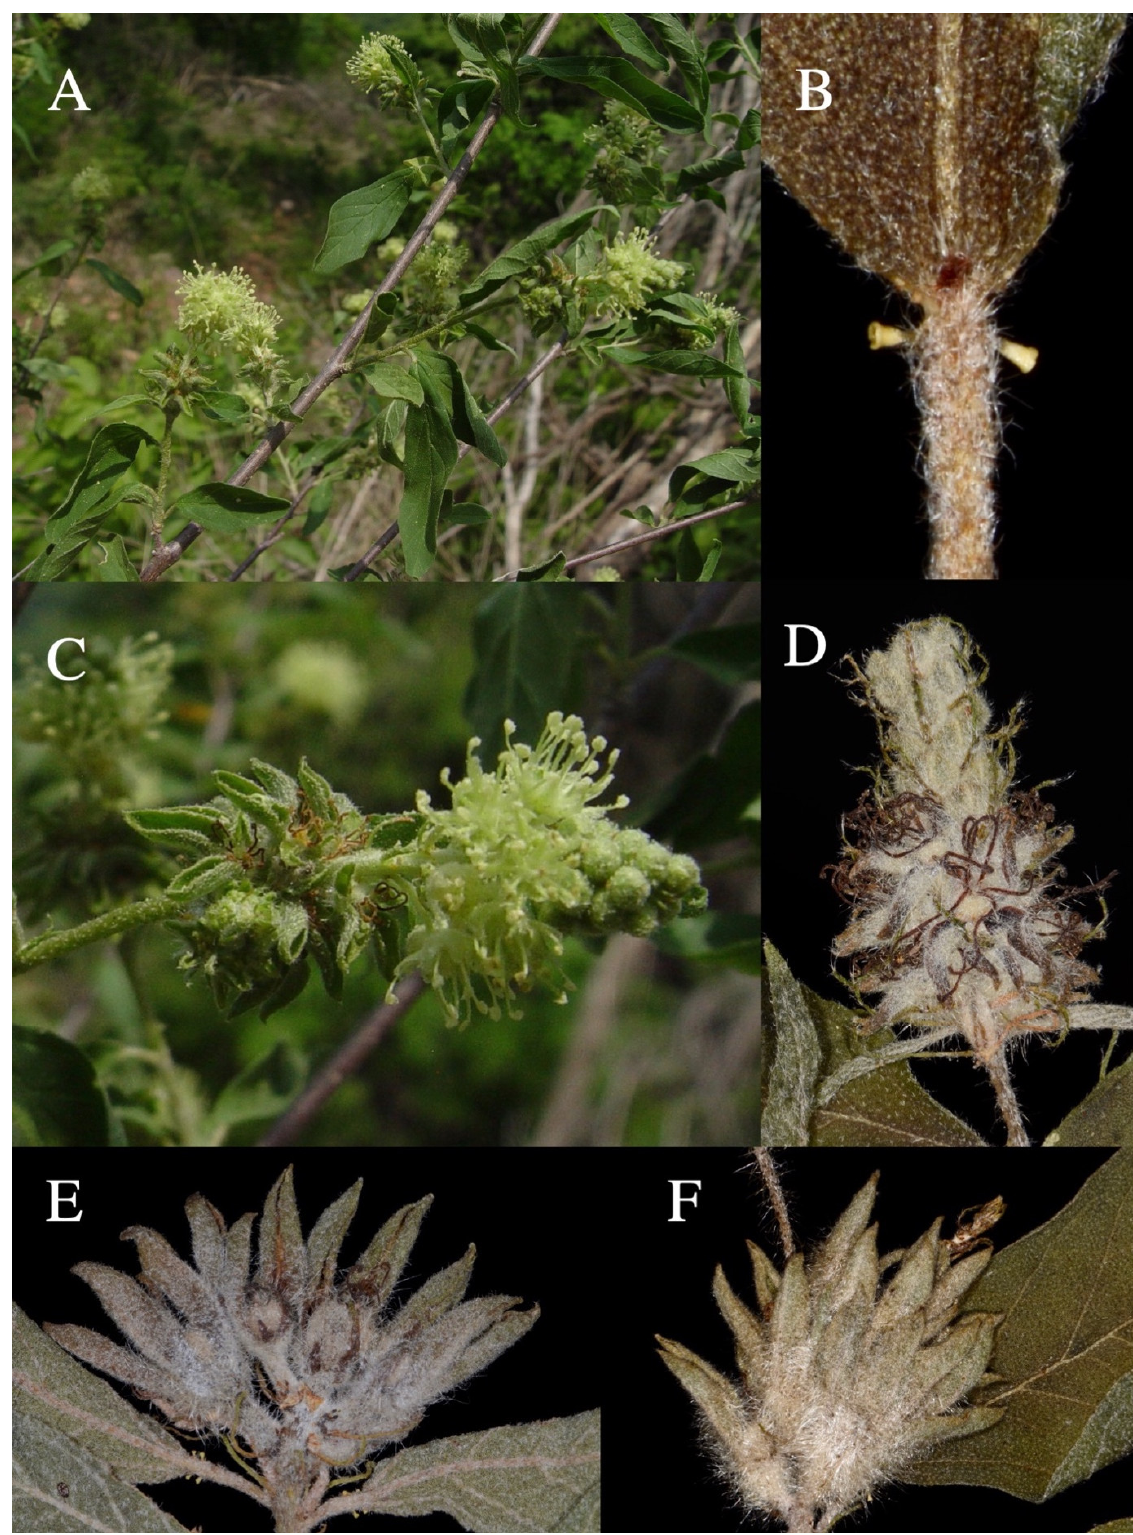
Figure A13. Croton rojasii sp. nov. ( A , B ). Flowering branches. ( C ) Petiole and lower leaf blade showing extrafloral nectaries. ( D ) Inflorescence with open pistillate flowers. ( E ) Young fruits with accrescent sepals; note petioles with four extrafloral nectaries. ( F ) Infructescence with large accrescent pistillate sepals. A and C photographed by Guillermo Ibarra and used with permission; B and D from Hern á ndez Esquivel et al. 24 ; E from Rangel-Landa 884 ; F from Rojas 85